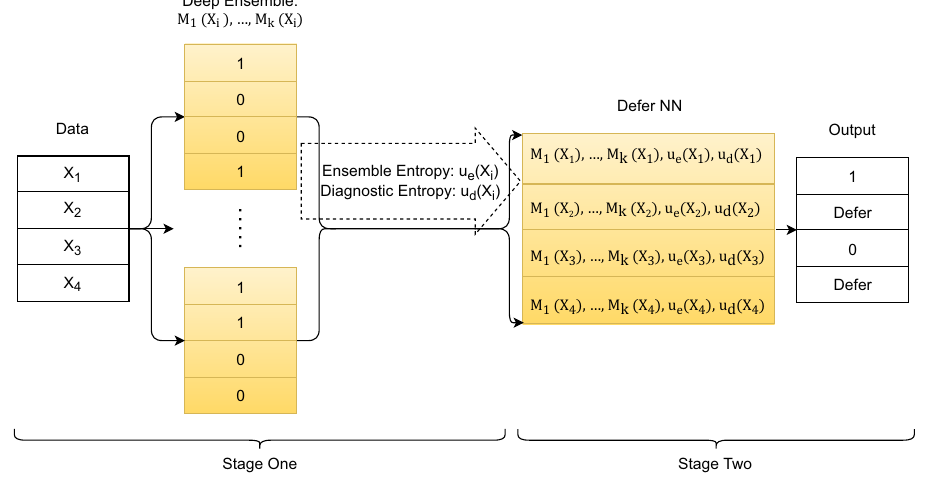
Figure 1. Learning to defer using ensemble predictions and their